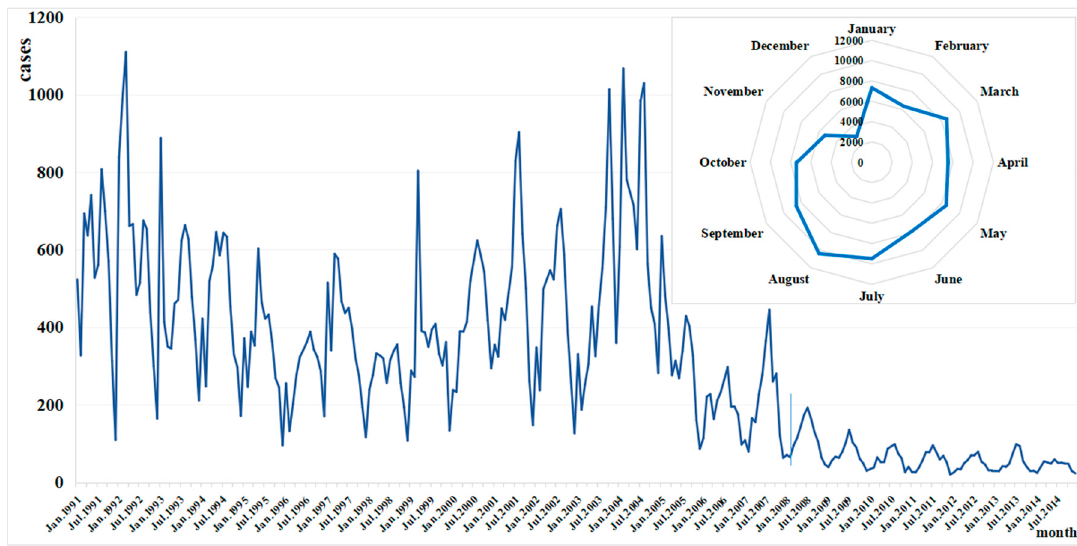
Figure 5. Monthly distribution of typhoid and paratyphoid cases in Zhejiang from 1991 to 2014.